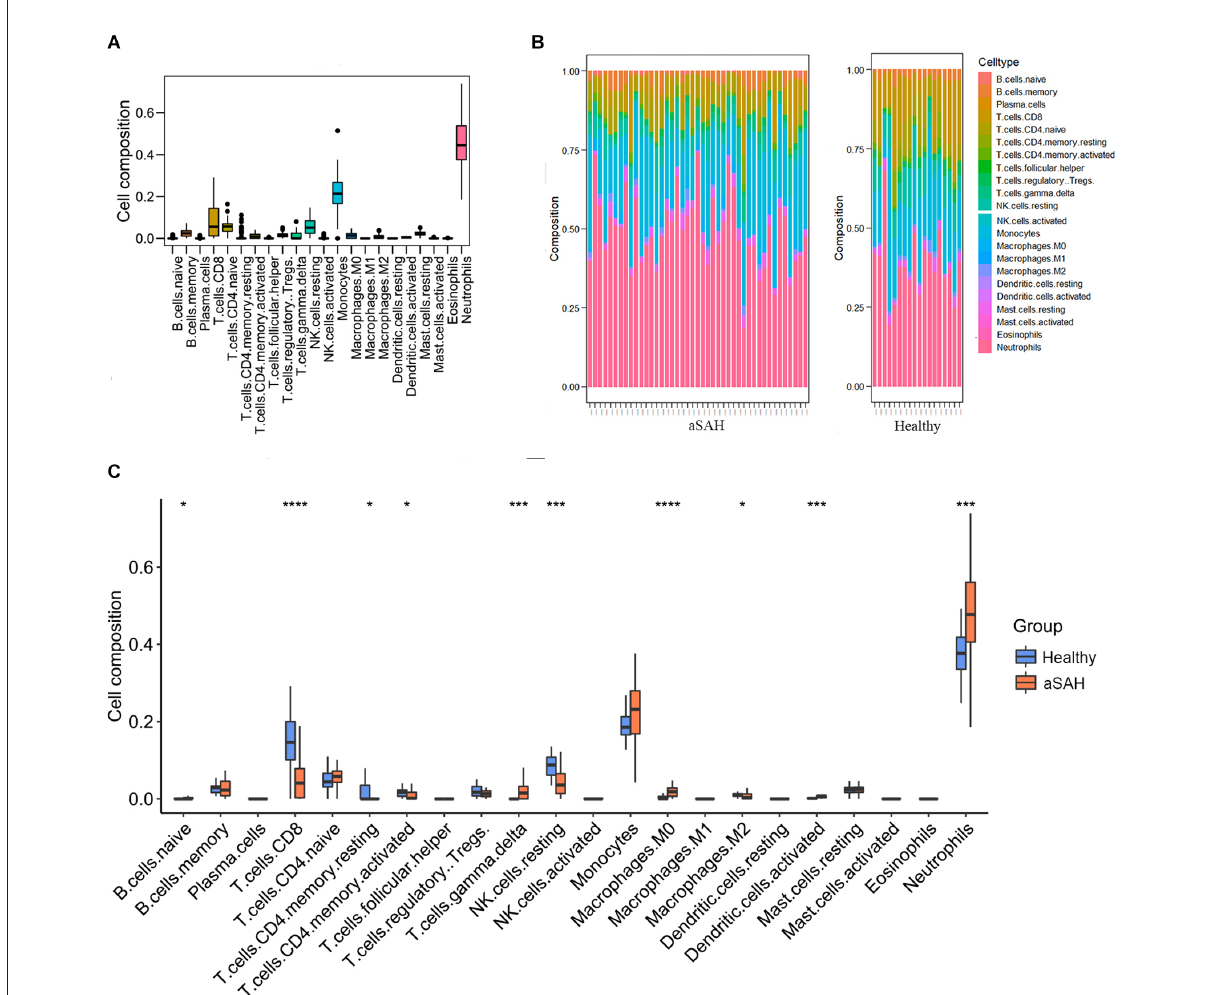
FIGURE3 Immune landscape in the arterial samples between aSAH and healthy groups analyzed by CIBERSORT method. (A) The heatmap showing the distribution of the 22 immune cells. (B) The bar chart showing the enrichment scores in aSAH and healthy control groups. (C) The boxplot comparing the cell compositions between aSAH and control groups. The statistical difference was compared by the Wilcoxon test (* p < 0.05, *** p < 0.001, **** p <